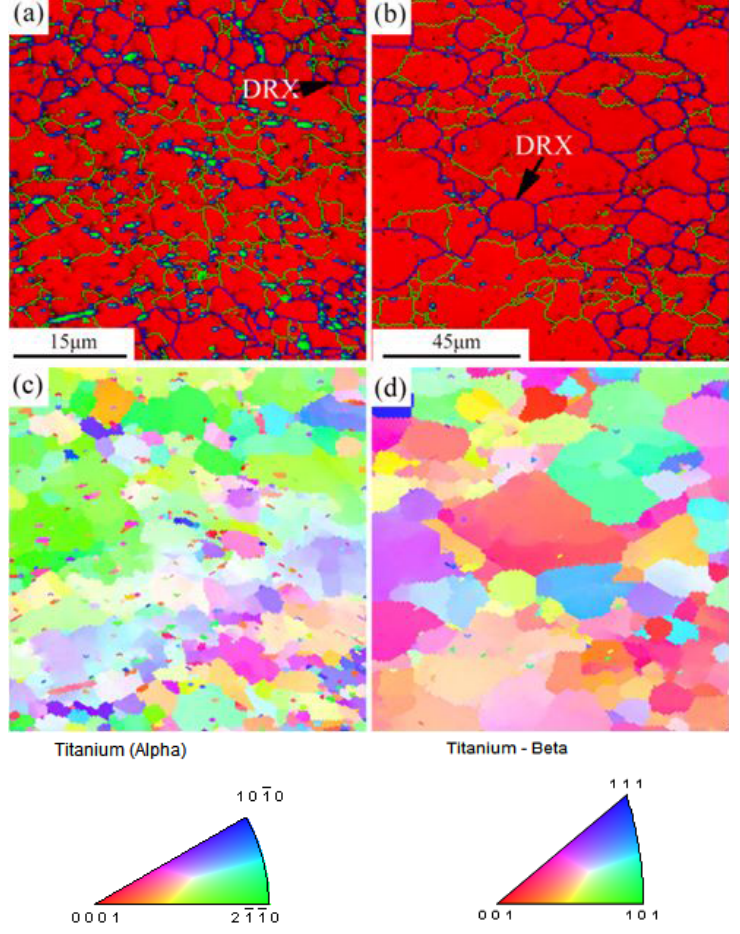
Figure 6. Electron backscattered diffraction (EBSD) images showing microstructure of the alloy deformed at 1003 K ( a ) and ( c ) 1078 K ( b ) and ( d ) with the strain rate of 0.001 s −1 . (In a and b ), the red field = β phase, green field = α phase, blue line = HAGBs, green line = LAGBs, DRX = dynamic